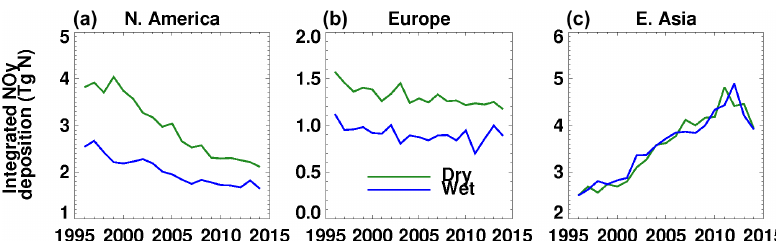
Figure 6. Time series of annually integrated dry and wet NO y deposition over specific regions (North America, Europe, and East Asia) as defined by the dashed rectangles in Fig. 5.